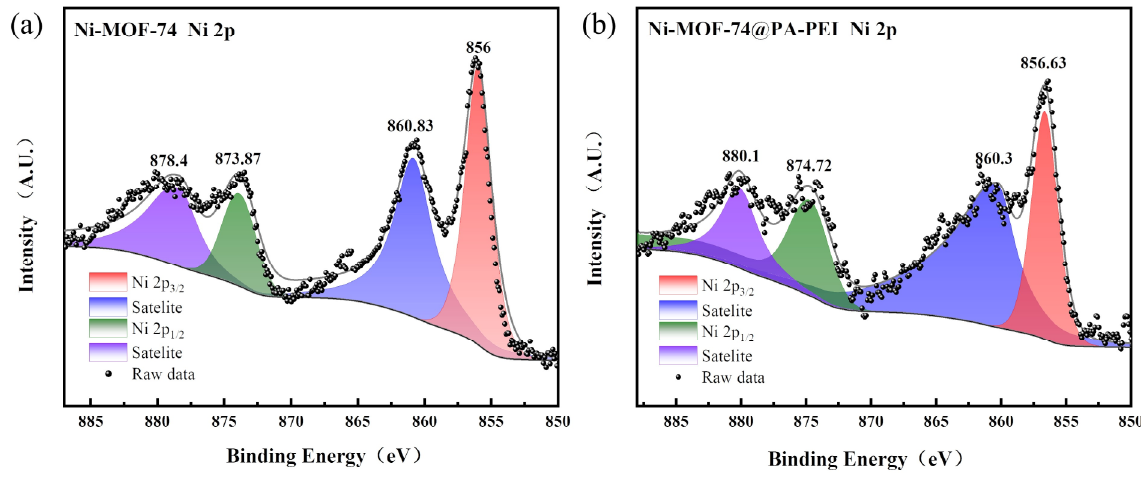
Figure 7. XPS spectra of Ni 2p for ( a ) Ni−MOF−74 and ( b )